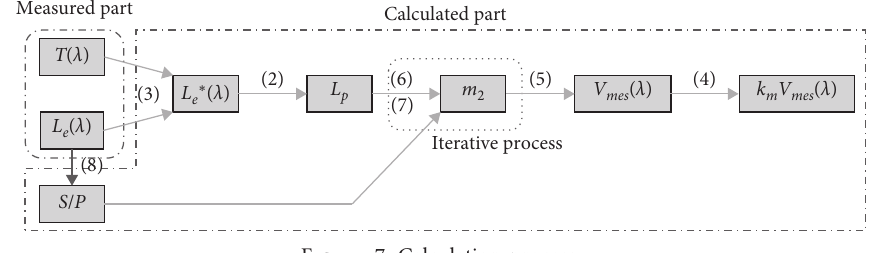
Figure 7: Calculation process.